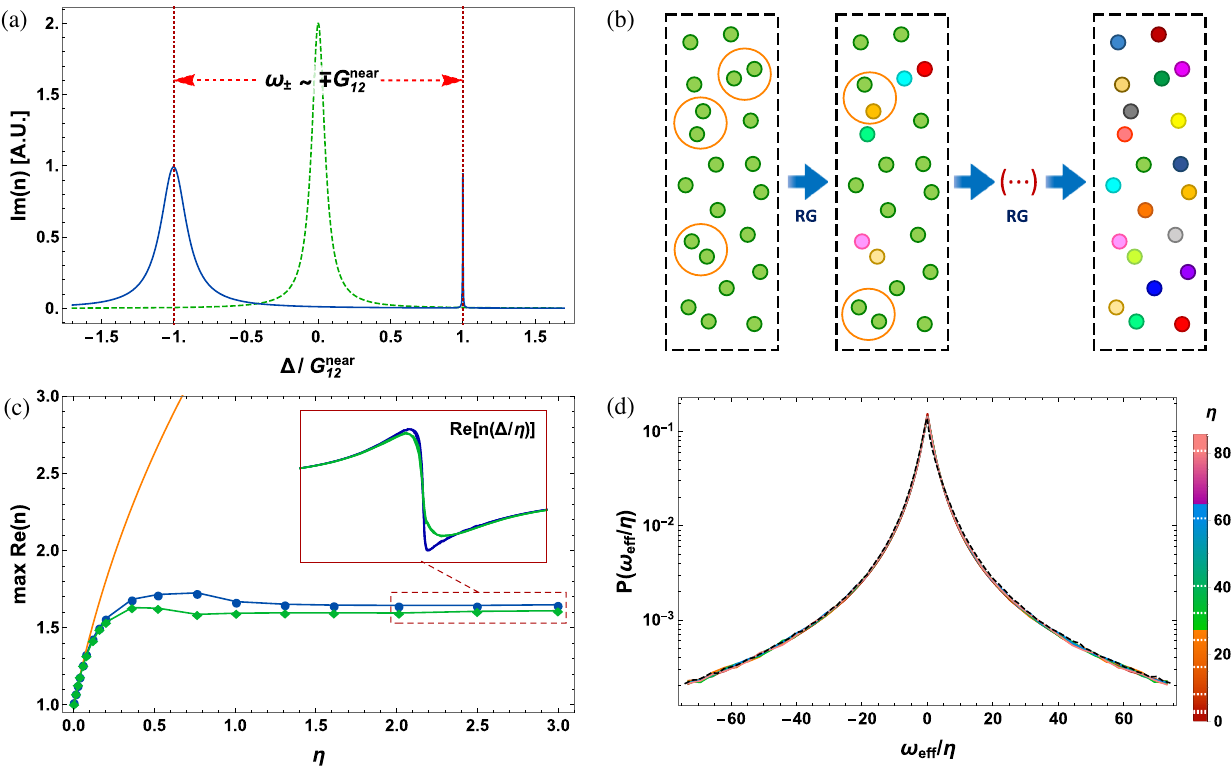
FIG. 4. Renormalization group analysis. (a) Representative optical response of two identical atoms separated by a distance ρ 12 ≪ 1 . Here, we plot the absorption spectrum (blue curve), which consists of two well-separated Lorentzians. The positions of the resonances are given approximately by ∓ G near 12 , where G near 12 ∝ 1 = ρ 3 12 is the near-field component of the Green ’ s function. To compare, we also plot twice the response of a single isolated atom (green dashed line). (b) Pictorial representation of the RG scheme for a many-atom system. At each step of the RG flow, the nearby pairs (identified by orange circles) that most strongly interact via their near fields are identified and replaced with atoms with different resonance frequencies (indicated by different colors) in such a way as to produce an equivalent optical response. At the end of the RG process (last panel), the overall system is equivalent to an inhomogeneously broadened ensemble of weakly interacting atoms. (c) Comparison between the maximum real refractive index predicted by the full coupled-dipole simulations of identical atoms (blue points), and the index of the equivalent, inhomogeneously broadened ensemble predicted by the RG (green). For each value of density, the maximum index is obtained by optimizing over detuning. For comparison, the MB and LL models both predict a maximum index given by the orange curve. The inset compares the rescaled spectra Re n ð Δ = η Þ of the RG (green) and full coupled-dipole (blue) simulations, given the points at densities η ≳ 2 . (d) Rescaled probability distribution of effective, inhomoge- = η Þ obtained from the application of the RG scheme. Given nine different values of the neously broadened, resonance frequencies P ð ω eff density η (ranging from η ≈ 2 . 5 up to η ≈ 80 ), the distributions of effective resonance frequencies are plotted with different colors, according to the bar on the right. The exact values chosen for the curves are emphasized by dotted white lines in the color bar. The curves at η ≈ 2 . 5 and η ≈ 3 are calculated using the cylindrical system studied in Fig. 3 (with thickness d ¼ 0 . 4 λ 0 and transverse radius 5 λ ω 0 . 55 λ l = η Þ at densities η > 3 are evaluated using a spherical geometry of radius r 0 ), while the distributions P ð 0 . Finally, cyl ¼ eff sph ¼ for the case of density η ≈ 3 , we plot (black dashed curve) the many-atom distribution of the eigenvalues of the near-field matrix − G near (also rescaled by a factor of 1 = η for consistency), as discussed further in Sec. V. All distributions are obtained by accumulating results from about 100 different configurations of atomic